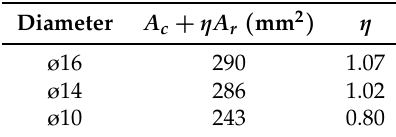
Table 3. Experimental results for various inner